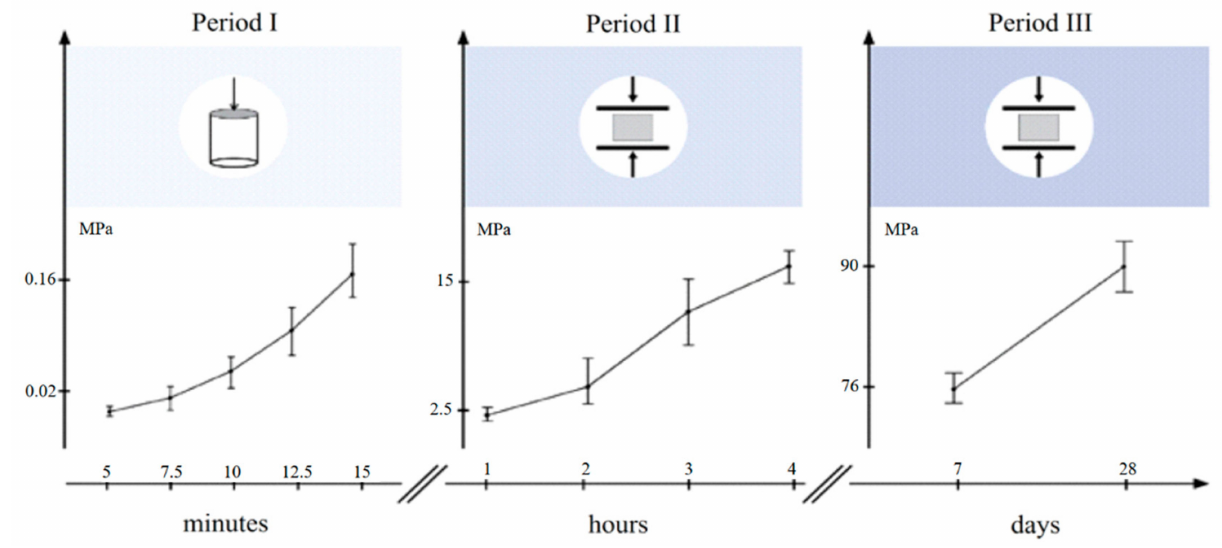
Figure 2. Testing of material strength in 3 different periods: initial strength ( left ) covering the first 15 min after placement, demolding strength ( center ) with the objective of reaching at least 15 MPs at 4 h, late strength ( right ) measured both after 7 days and 28